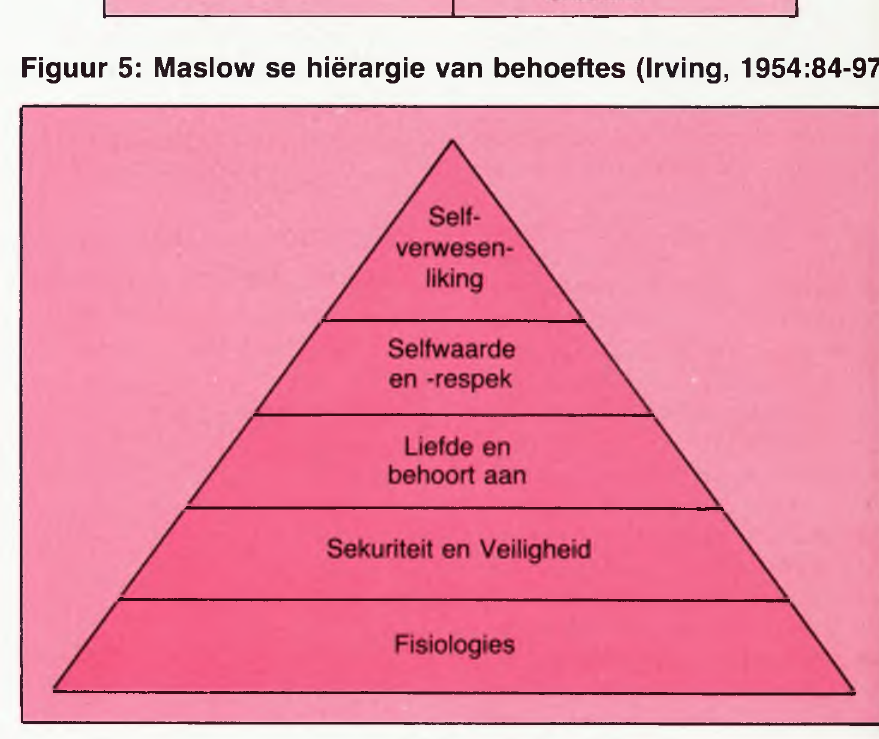
Figuur 5: Maslow se hiërargie van behoeftes (Irving,